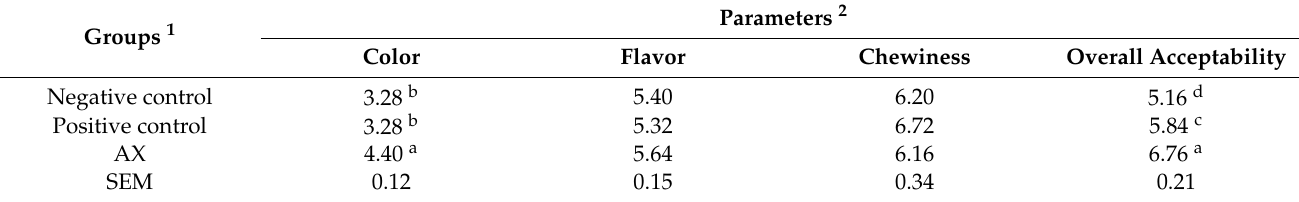
Table 3. Sensory properties of emulsified sausages with different antioxidants.